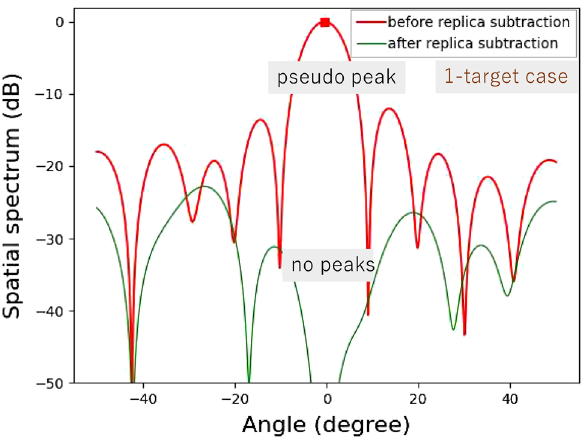
Figure 10. Experimental results for horizontal angle estimation for a single-target case.